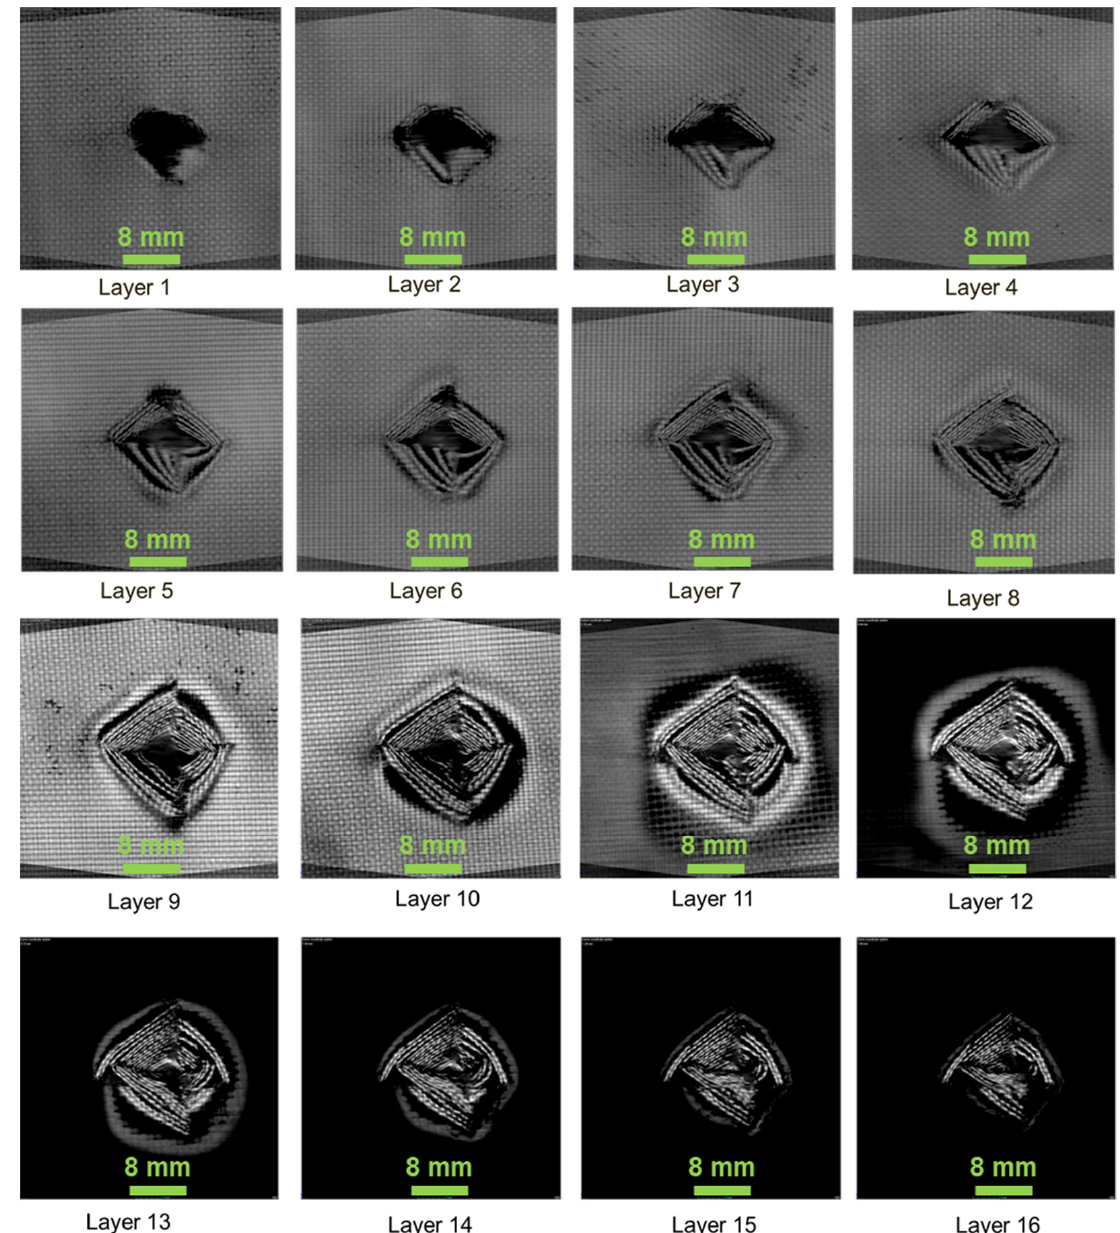
k /0 E /0 k —composite laminate failure on each 14 1